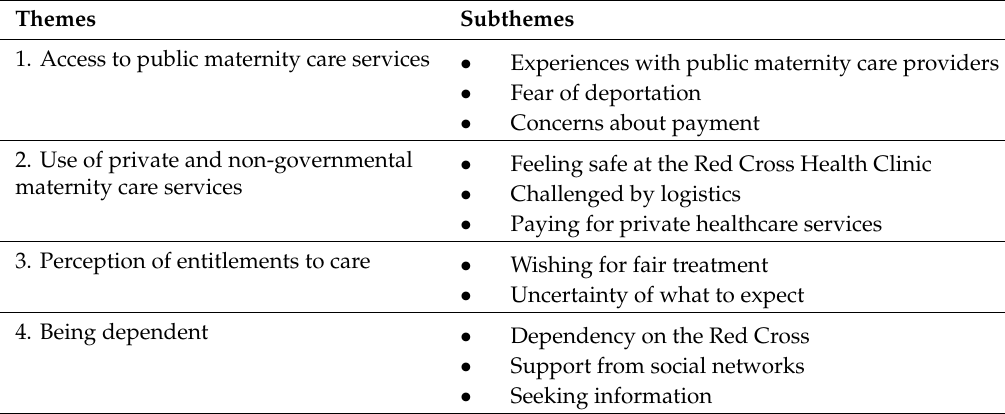
Table 2. Themes and subthemes of the